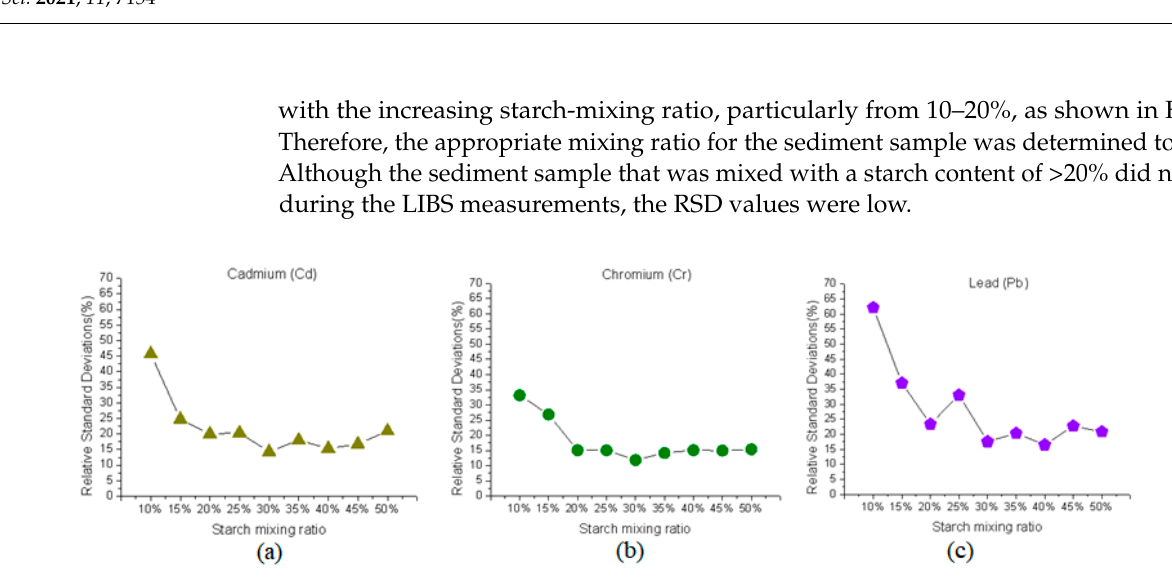
Figure 3. RSD results with an increasing starch-mixing ratio: ( a ) Cd at 361.051 nm, ( b ) Cr at 274.898 nm, and ( c ) Pb at 537.210 nm.